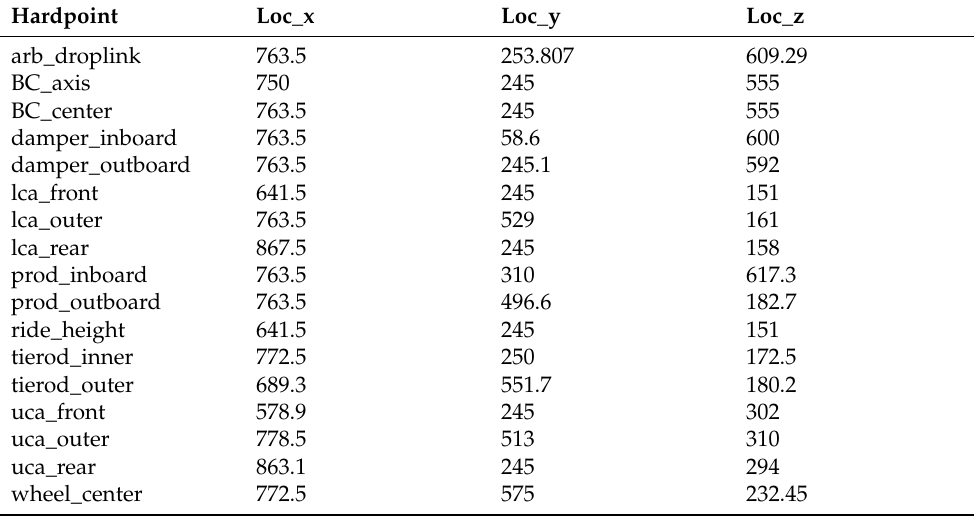
Figure A2. Details of the double wishbone rear right suspension system. Table A2. Hardpoint locations of the front right suspension expressed in the model global reference